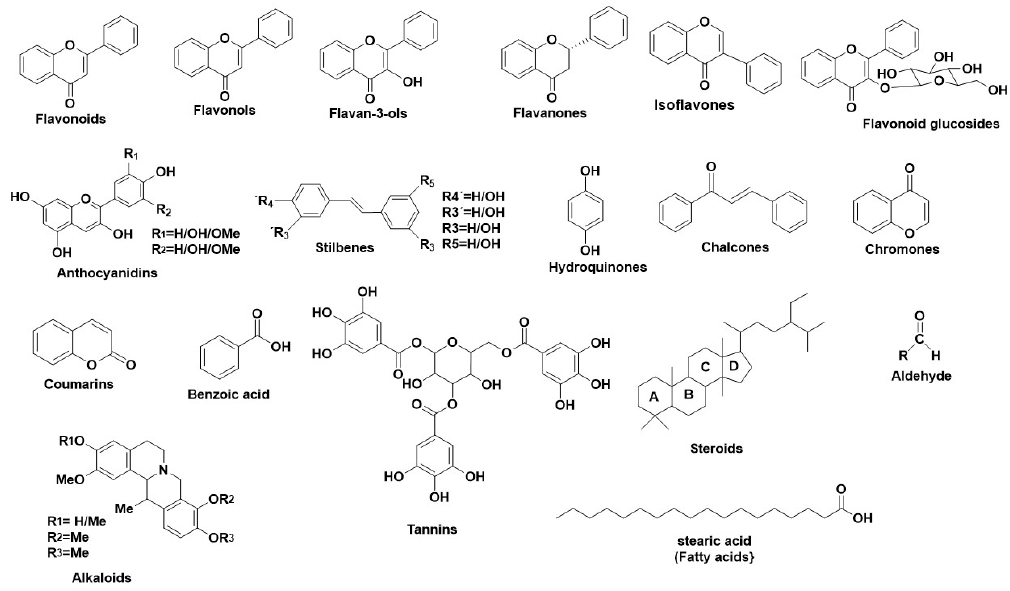
Figure 3. Main structural scaffolds which have been marked as potent Tyr